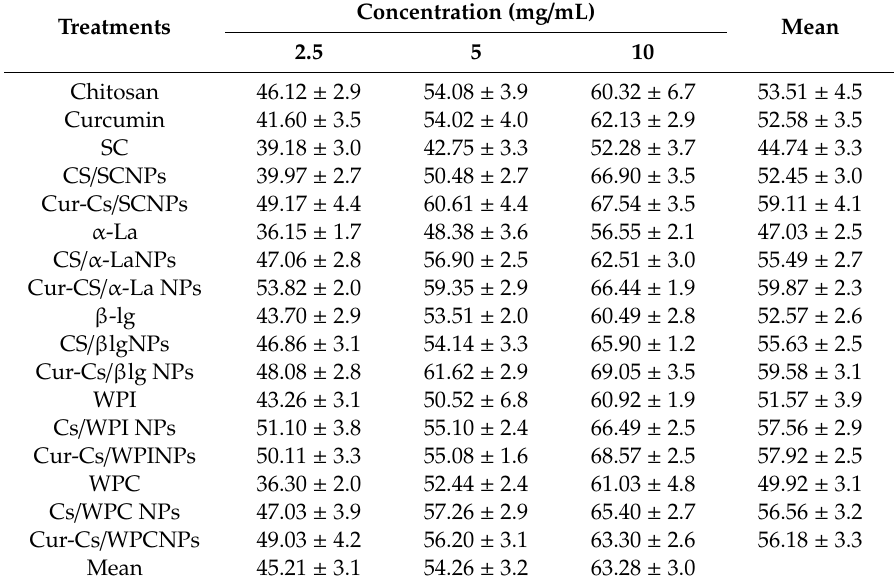
Table 2. Antioxidant activity (radical scavenging activity %) of di ff erent concentrations of native